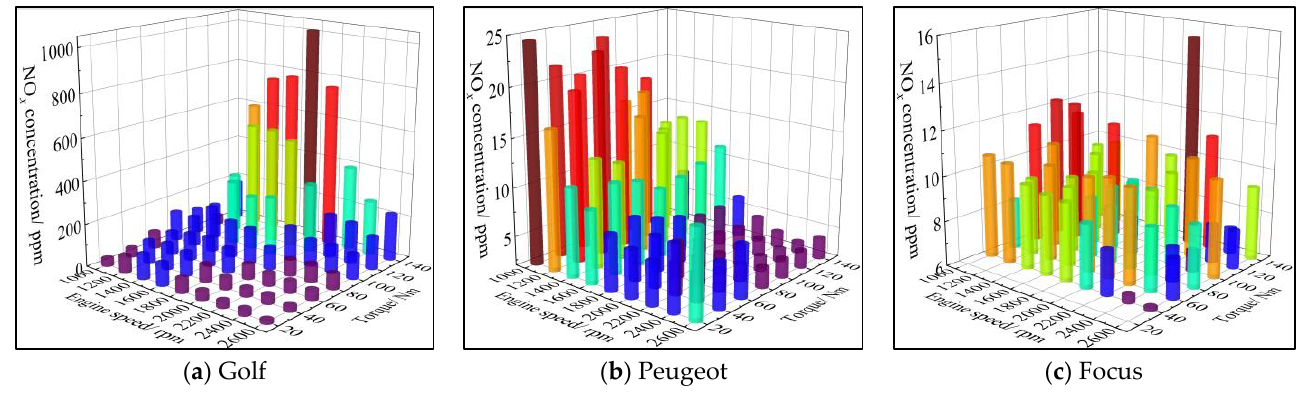
Figure 9. NO x concentration vs. engine speed and torque.